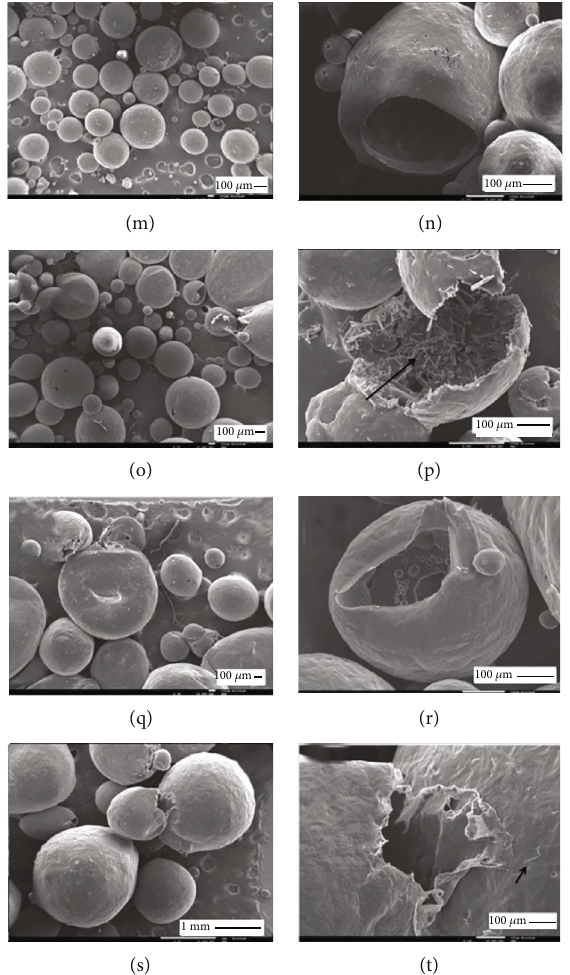
Figure 45: SEM micrographs of the polycaprolactone microcapsules; the arrow in Figure 44(p) indicates the presence of encapsulated naringin crystals. The same happens in Figure 44(l)